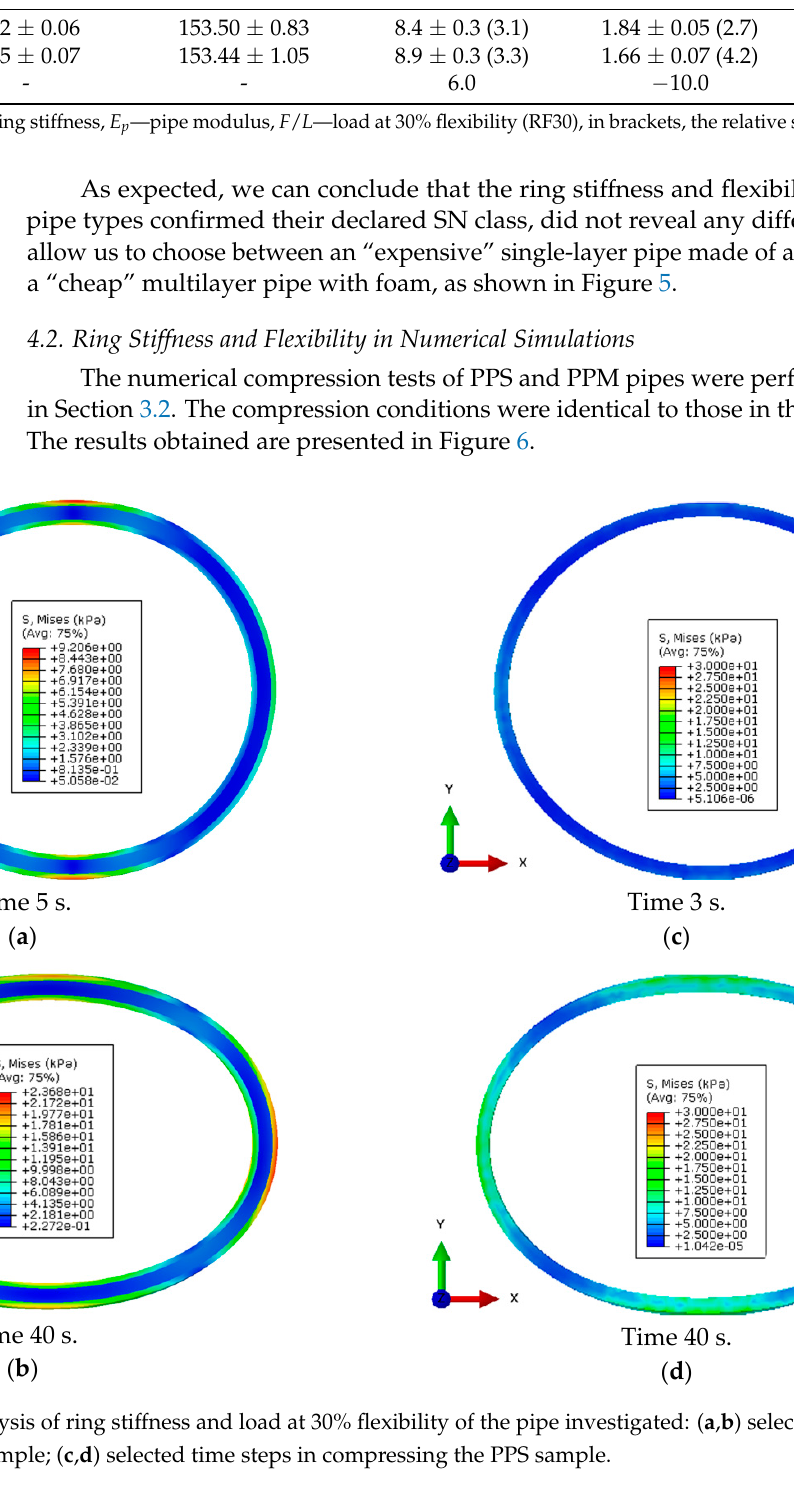
Table 3. Test results for the ring stiffness and flexibility of PPS and PPM pipes with a nominal/external diameter D = 110 mm.